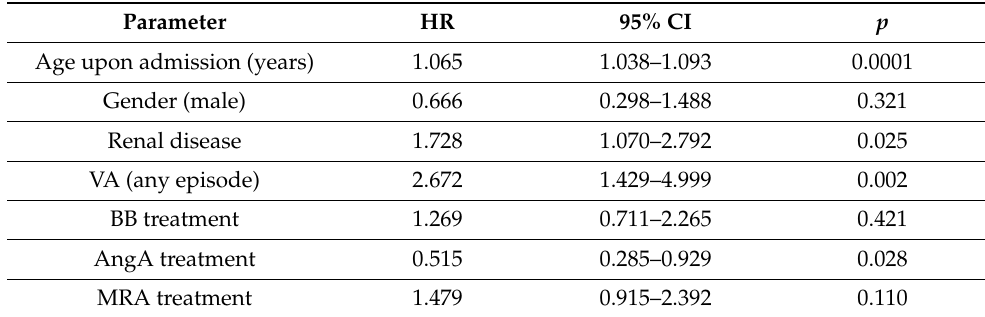
Table 5. Cox proportional-hazards multivariate model for overall mortality.